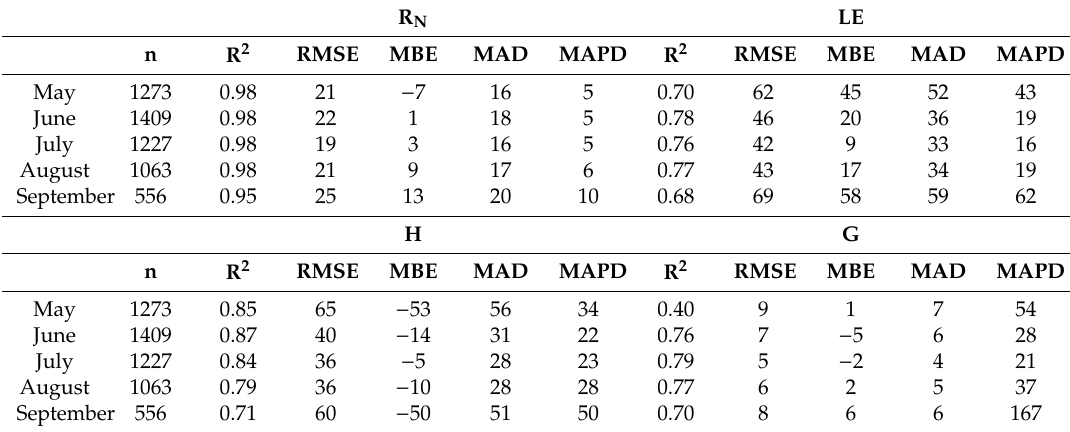
Table 4. Monthly results of the model agreement and error estimation compared to observed flux tower data at the birch setting using an initial TSEB α PTC value of 0.9. n is the number of 30-min periods selected. Error estimators (RMSE, MBE, MAD) are in W · m − 2 while MAPD is in